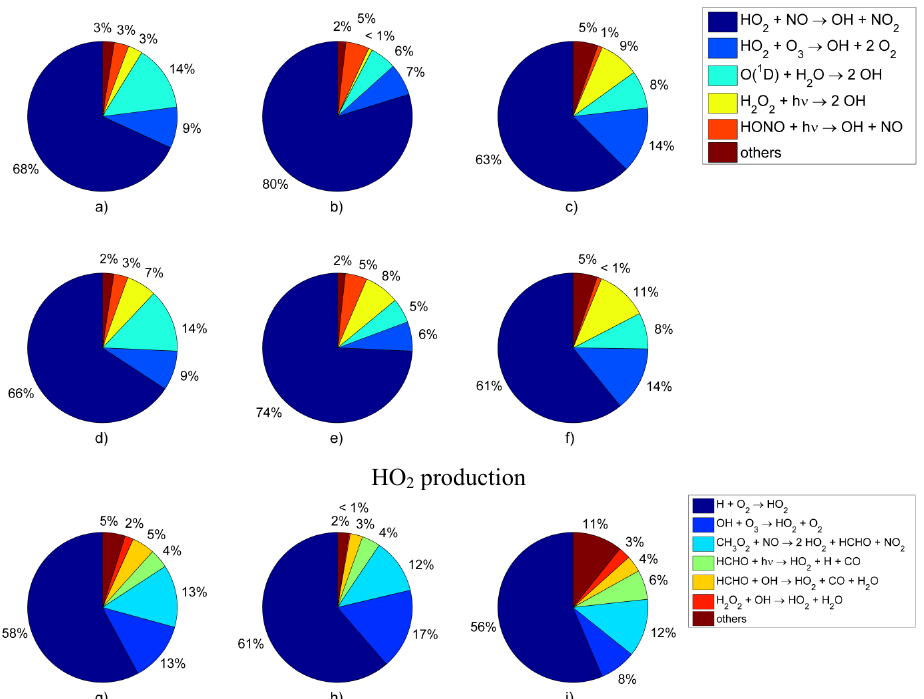
Figure 12: Shown is the relative contribution of the main OH and HO 2 forming reactions to the total OH and HO 2 production during northern flight tracks, southern flight tracks and for the conditions the global model tends to underestimate the OH mixing ratio. Subplots (d) , (e) and (f) show the OH formation with simulated H 2 O 2 corrected to observed values.